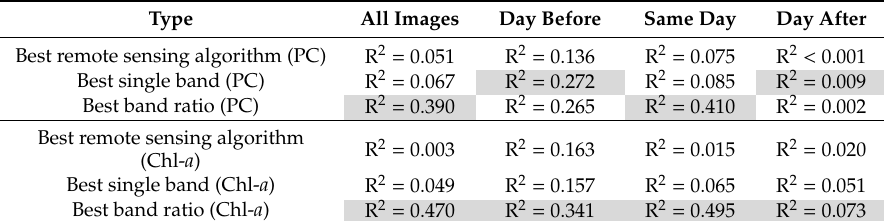
Table 4. R 2 values for all tested algorithms.